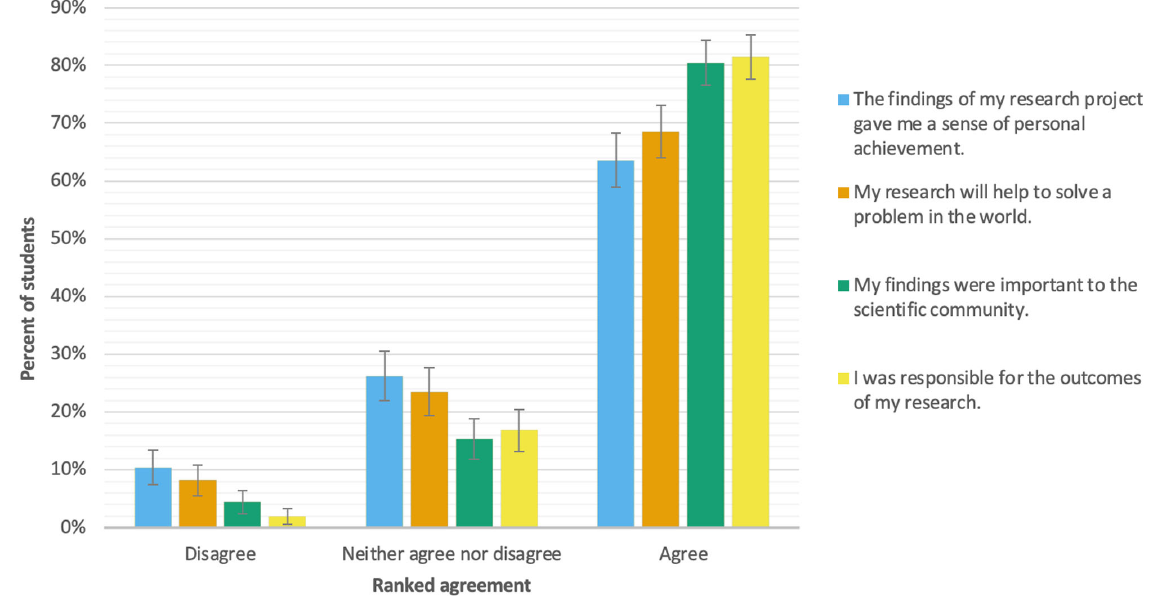
FIG. 5. Student responses to the postcourse survey questions measuring attitudes toward their research experience. Students responded to a 5-point Likert scale from “ strongly disagree ” to “ strongly agree. ” The responses presented in the graph have been collapsed to a 3-point scale. The uncertainty was calculated using the 95% binomial confidence interval with n ¼ 404 .